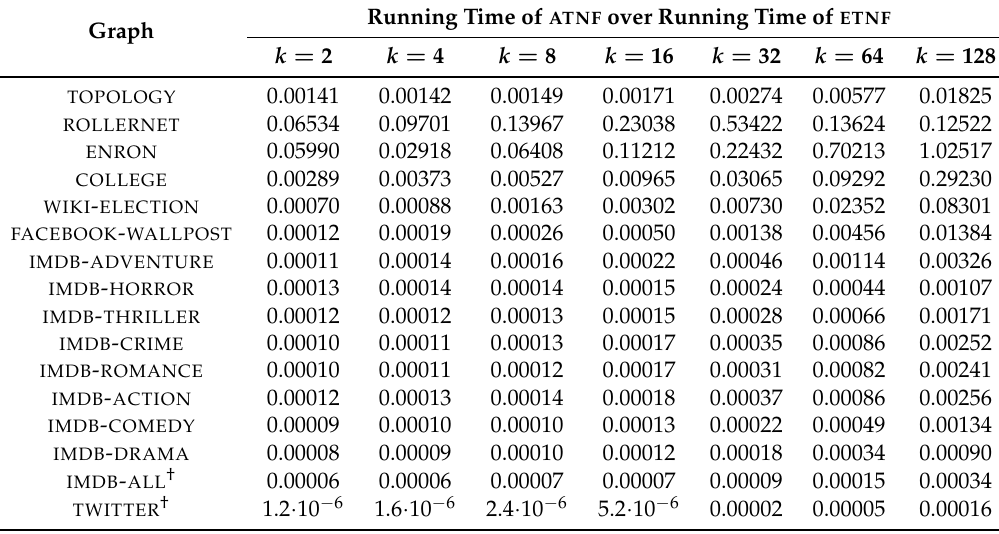
Table 5. Ratio between the running time of ATNF and the one of ETNF for different values of k (lower is better). The values for the graphs marked with † are estimated due to the computational limits of ETNF